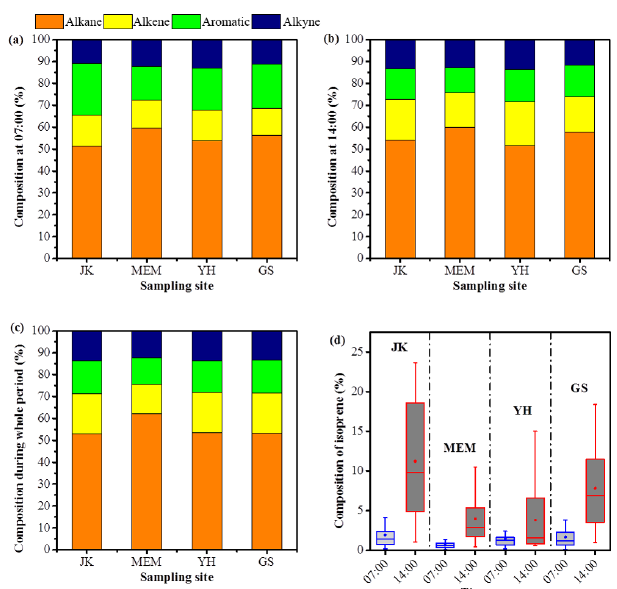
Figure 5. Compositions of major organic classes at 07:00LT (a) , 14:00LT (b) and during the whole sampling period (c) at the four sites, and the box plot for the composition of isoprene at 07:00 and 14:00LT for each site. The whiskers show the 5–95th percentiles, and the box shows the 25–75th percentiles. The solid dots represent the arithmetic average, and the line in the box shows the median (d)